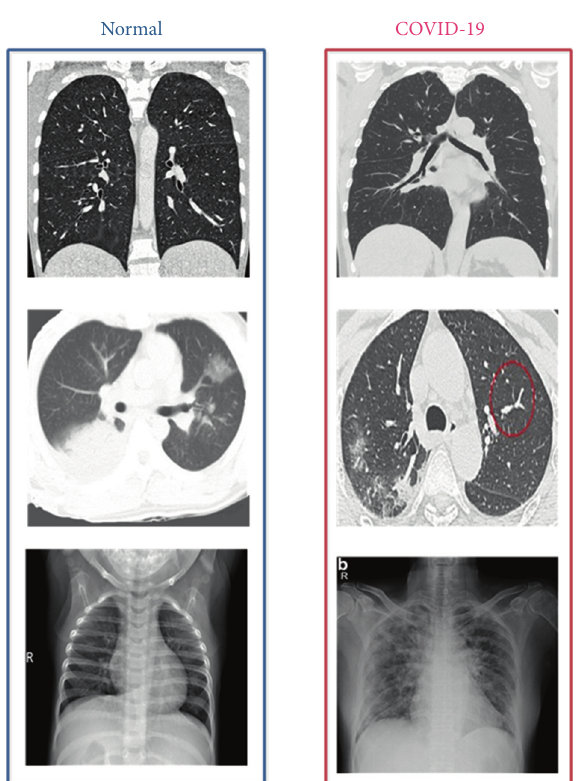
Figure 4: Example of X-ray and CTimages of a normal patient and a COVID-19 patient.